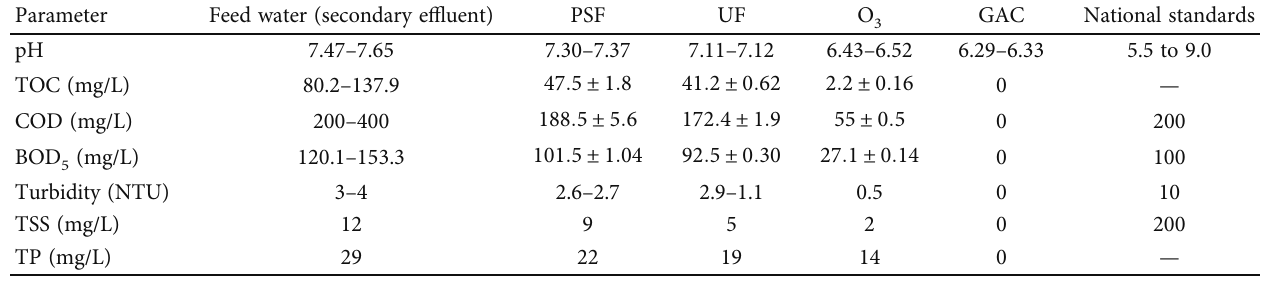
Table 2: Physico-chemical characterization of feed water, treated water quality, and National standards for reuse and discharge of wastewater.